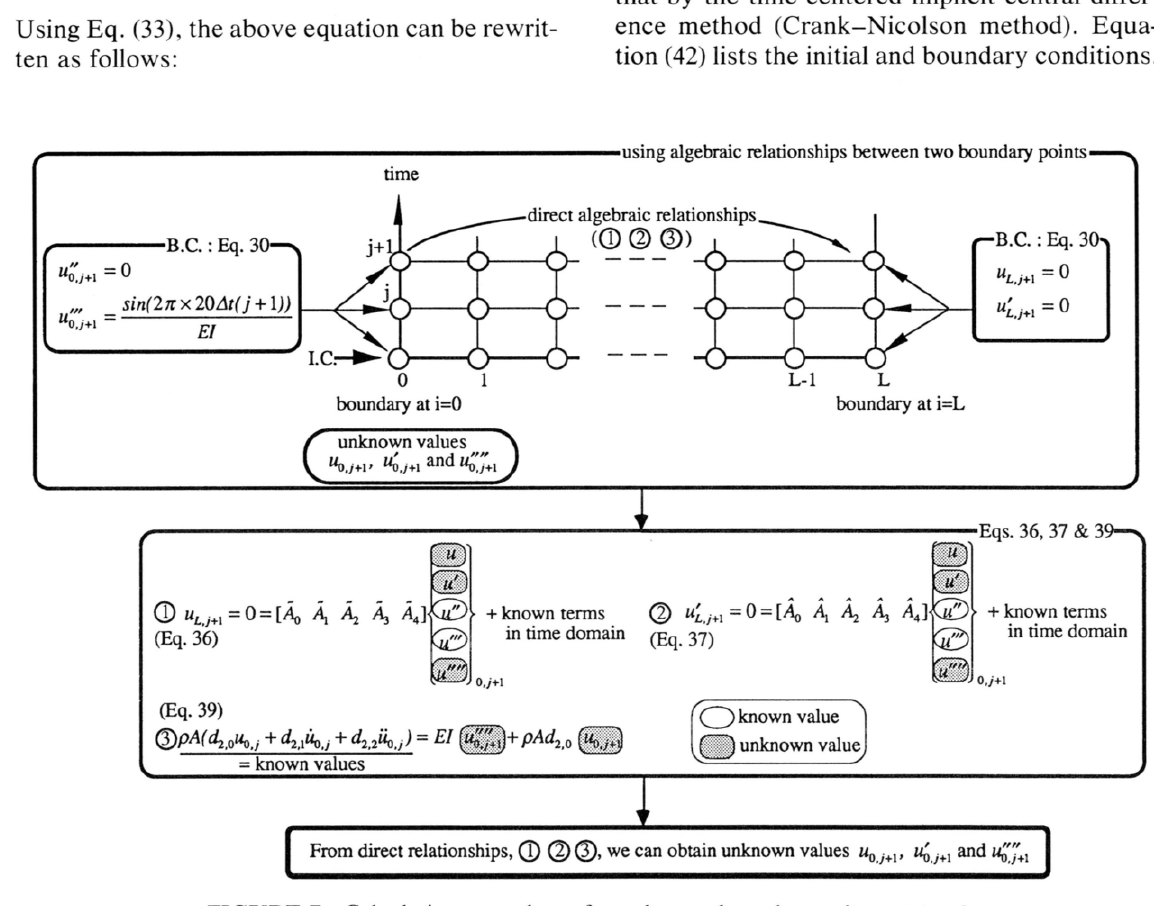
FIGURE 7 Calculating procedures for unknown boundary values at i =